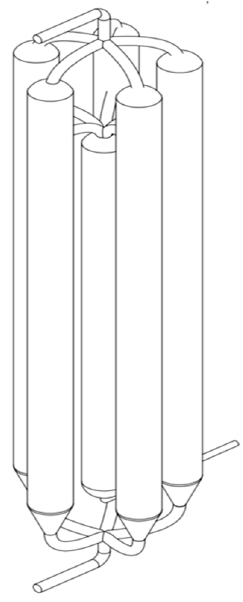
Figure 2. Schematic diagram of the parallel vertical separator.